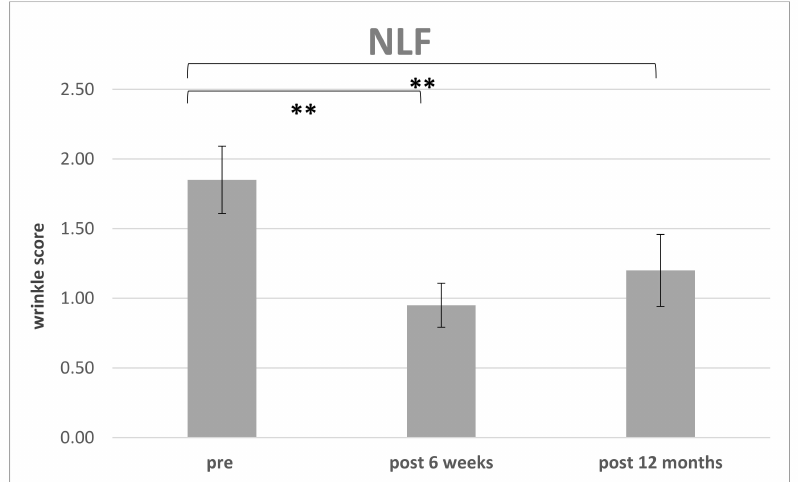
Figure 8. Improvement of the wrinkle severity scale related to the nasolabial fold (NLF): Comparison of WSS preoperative to 6 weeks and 12 months postoperative (** p <